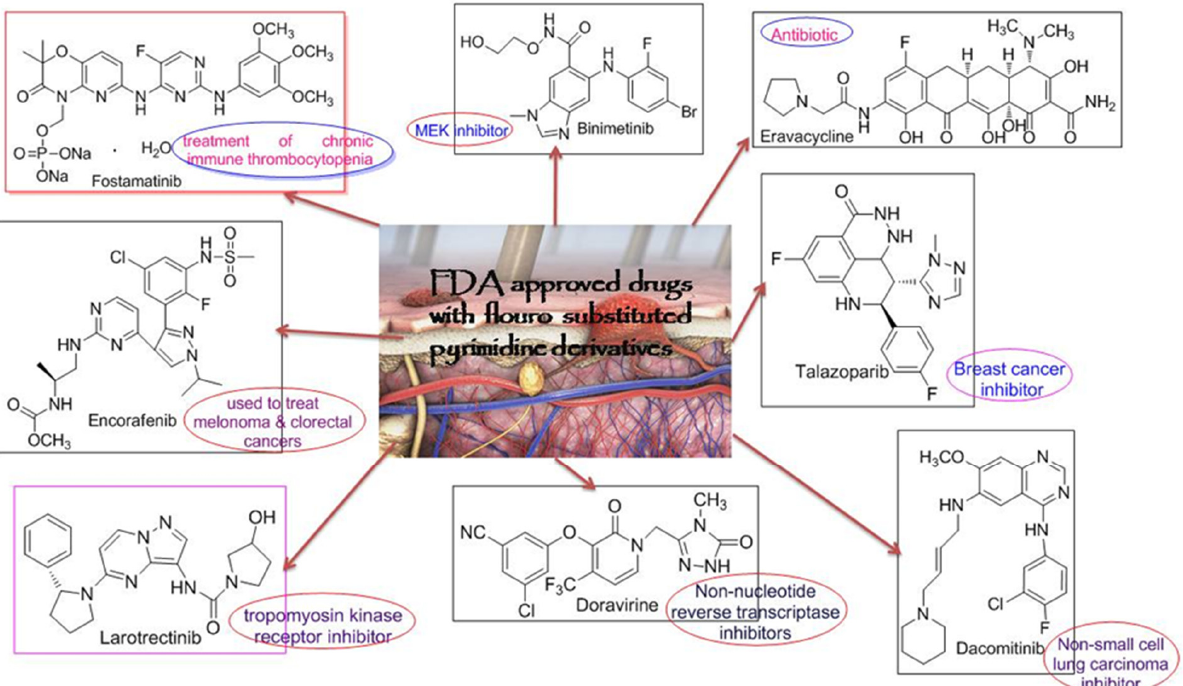
Figure 3. FDA approved drugs with pyrimidine skeleton having fluoro-substitution.